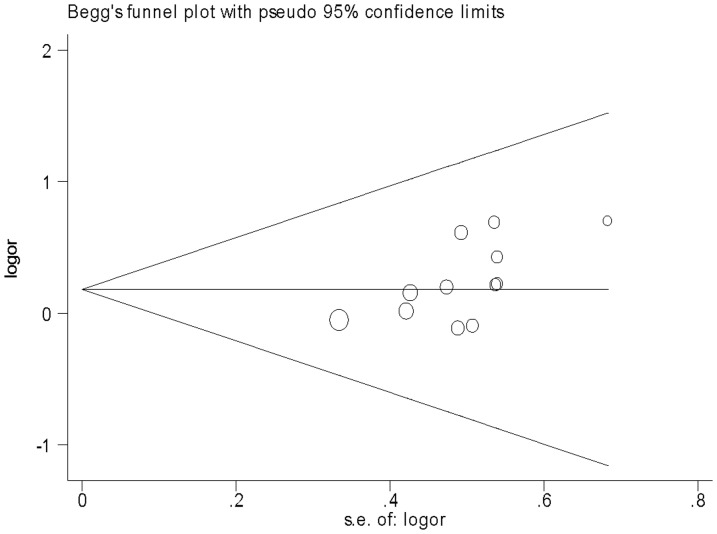
Funnel plot for publication bias in selection of studies on the CTLA-4 +49 A/G polymorphism (AA vs. AG+GG).